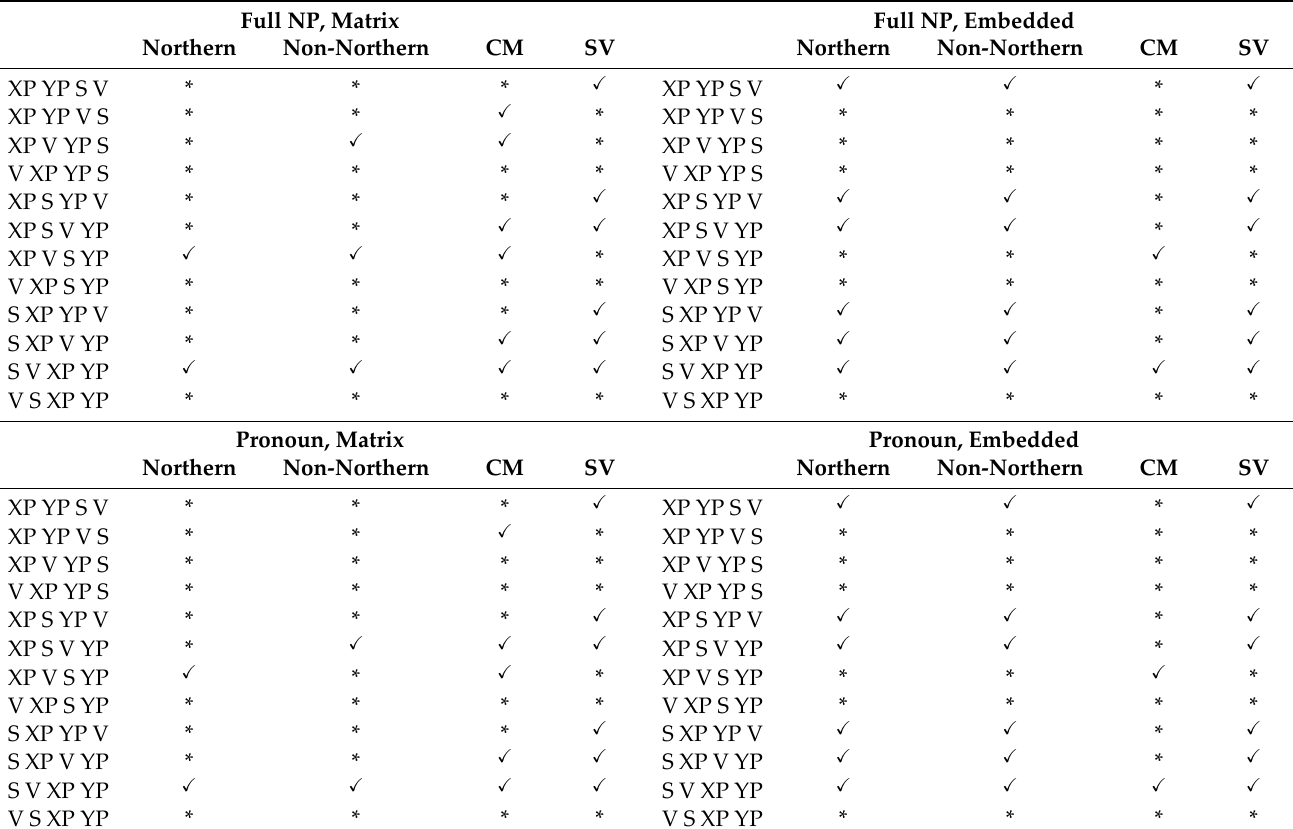
Table 1. Orders which can be generated by the northern and non‑northern V2 grammars, the CM grammar, and the SV grammar. Full NP, Matrix Full NP, Embedded